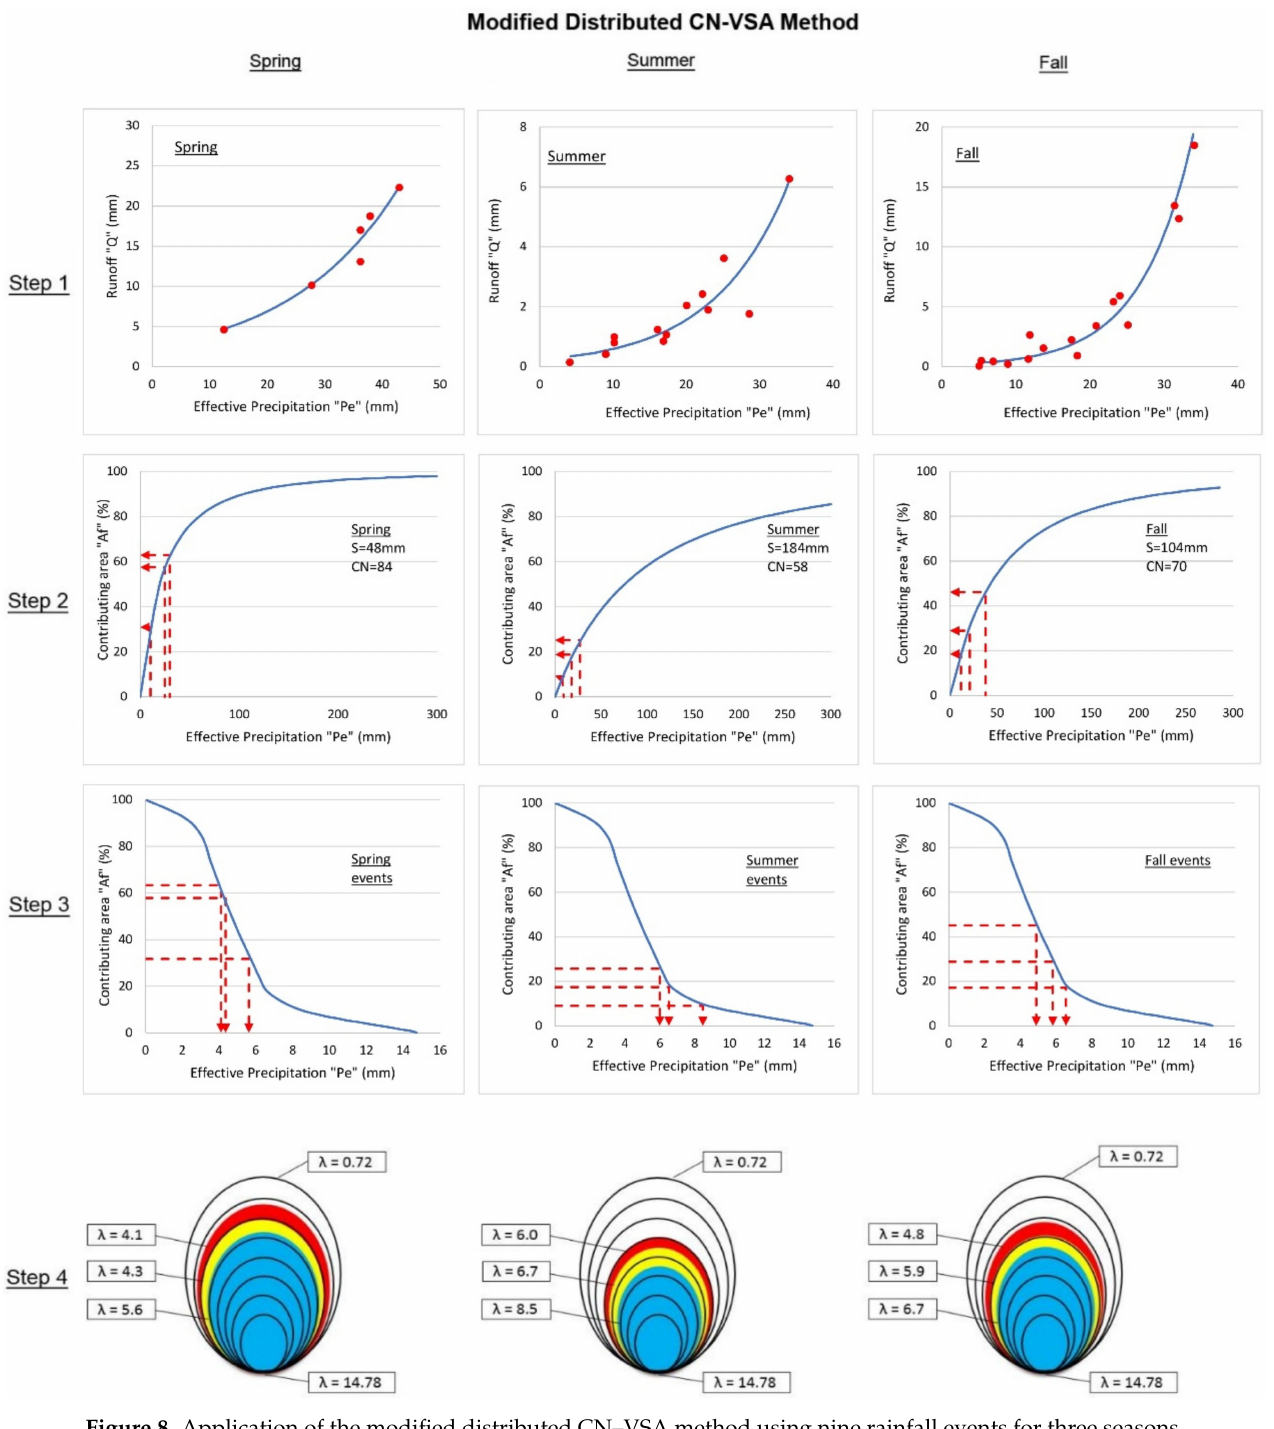
Figure 8. Application of the modified distributed CN–VSA method using nine rainfall events for three